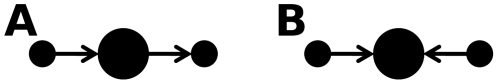
A 3-node network examples demonstrating how individual centrality metrics were measured.A) Betweenness centrality: individual in the middle is the necessary intermediary between the left and right individual, as it lies on the shortest path between those individuals; the middle individual therefore has higher individual betweenness centrality than the other two individuals; B) In-degree centrality: both left and right individual have connections towards the middle individual, making the middle individual ‘popular’ as a partner; middle individual therefore has higher individual in-degree centrality than the other two individuals.